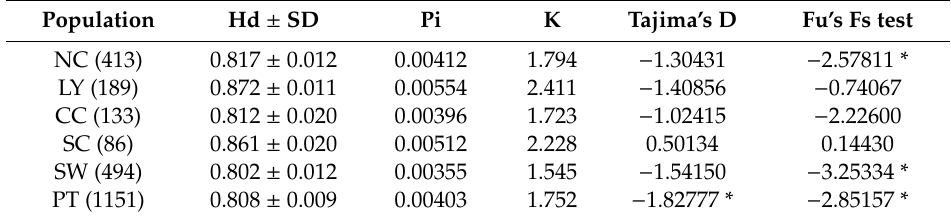
Table 1. Neutrality test and genetic diversity metrics of six populations of Chinese native